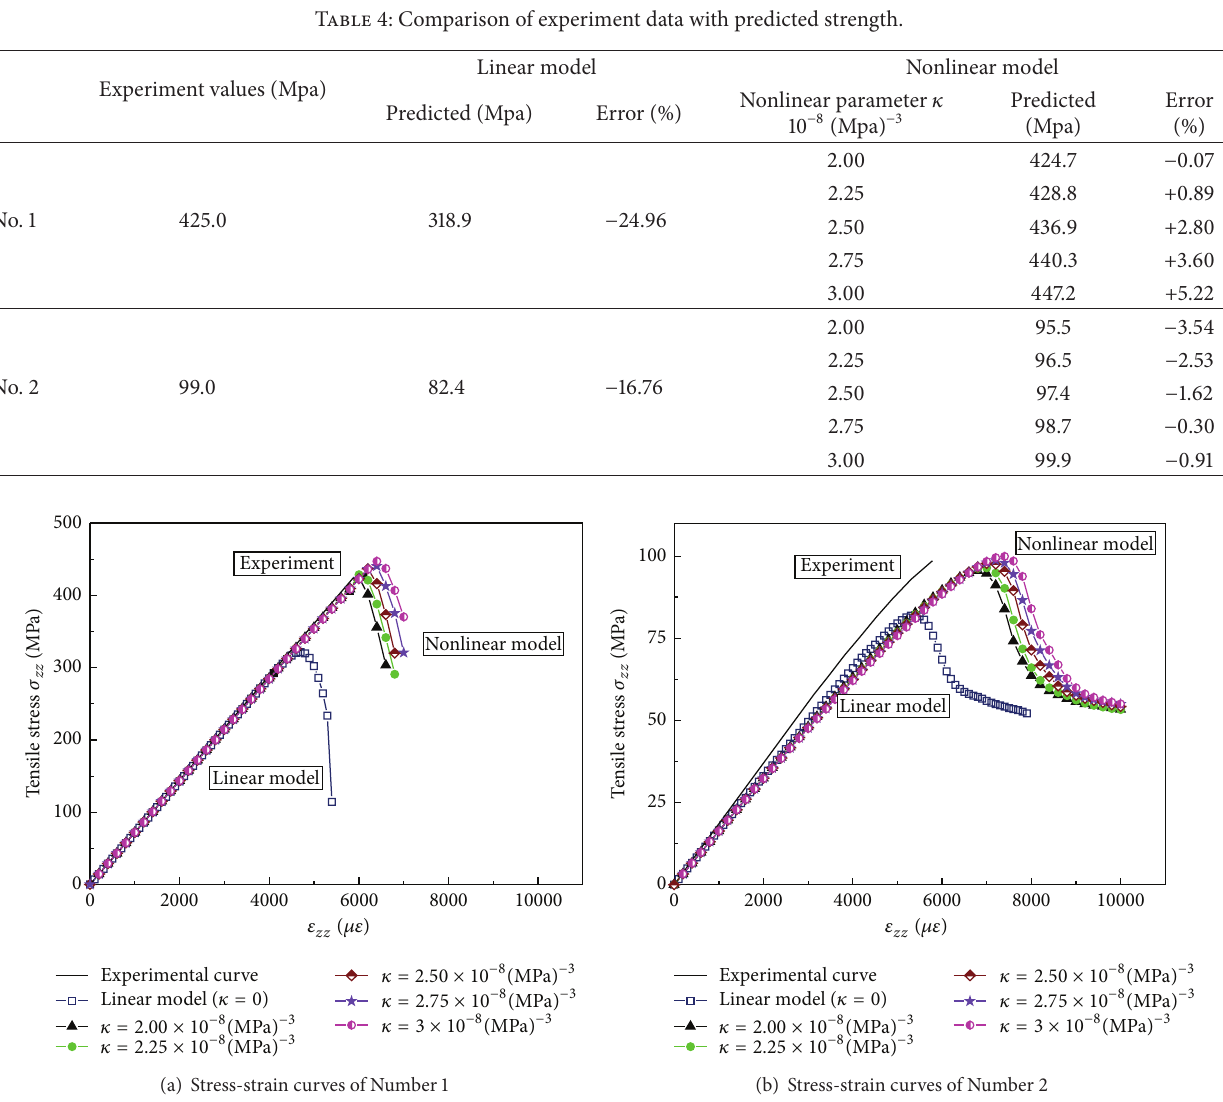
Figure 7: Tensile stress-strain